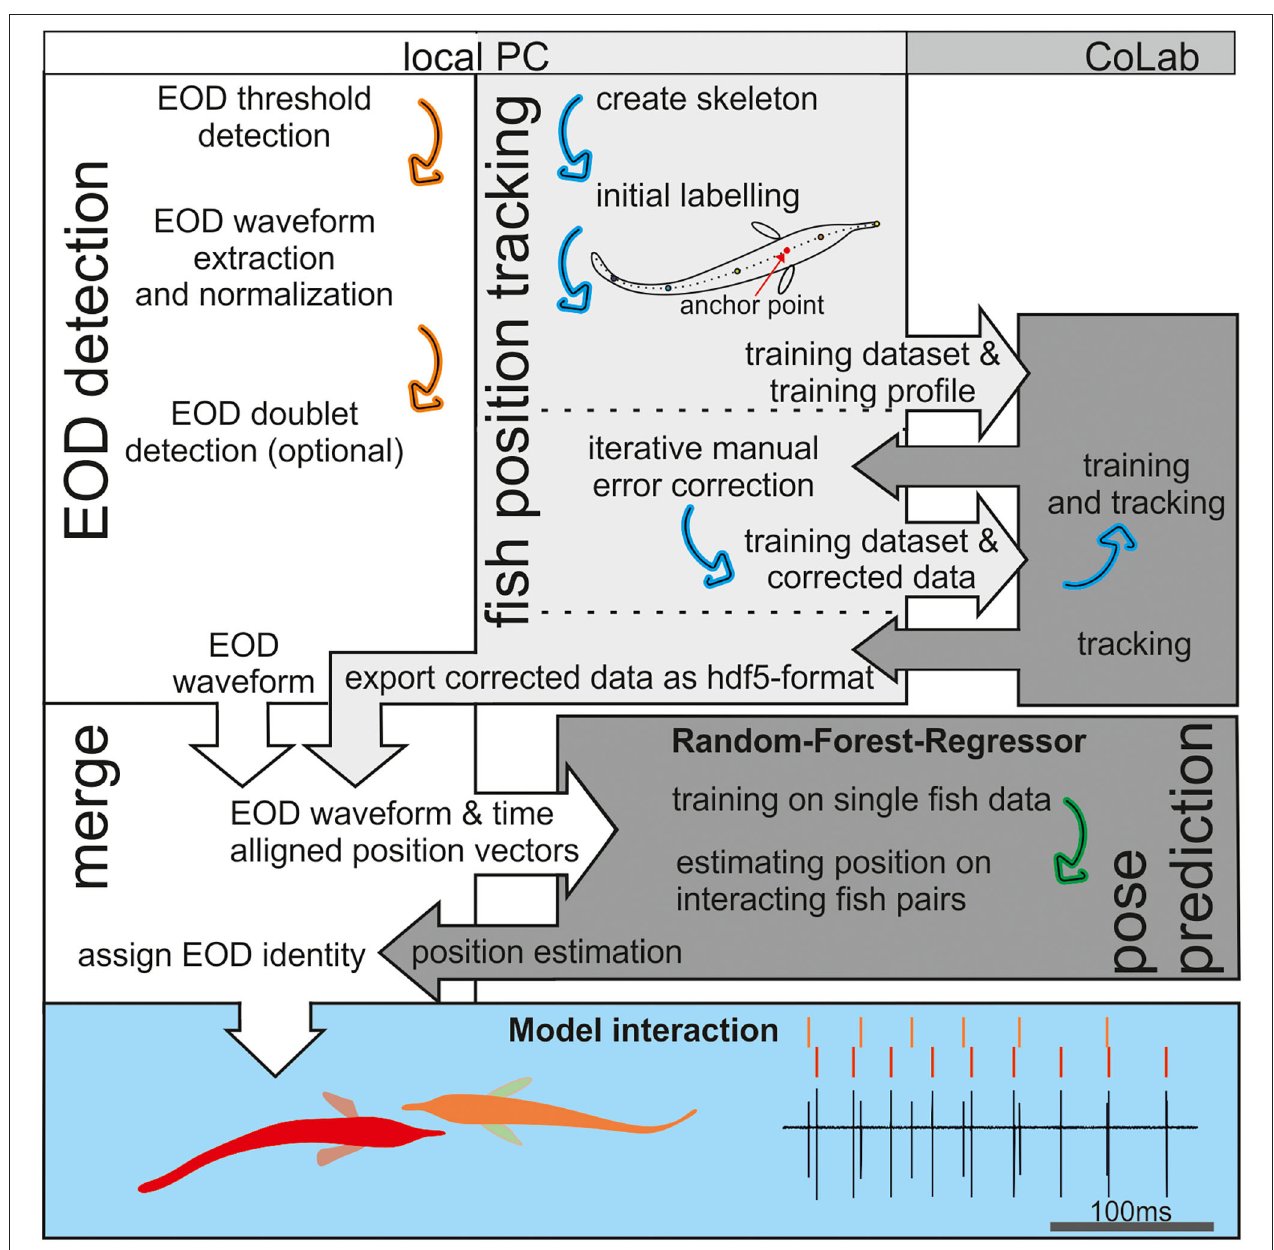
FIGURE 2 | An Illustration of the workflow. Electric organ discharge (EOD) detection was done in Matlab (white background), whereas fish tracking and pose estimation were based on Python (gray). The tracking in the open-source package social leap estimates animal poses (SLEAP) is based on deep neuronal networks that are computational demanding. Therefore, we relayed the training and final tracking of the data onto the CoLab platform (medium gray). The RFR (dark gray) was trained using the EOD waveform vectors as an input and the tracked (single fish) position data as the target. After training, the EOD waveform vectors were used to estimate fish position. This estimate from the RFR then was compared to the tracked fish position to assign the EOD identity in Matlab (see also Figure 7 ). The later behavioral analysis of agonistic behavior relied on the data set generate in this way to analyze the electrosensory information provided by the active and passive electrosensory system during the observed behavior (blue